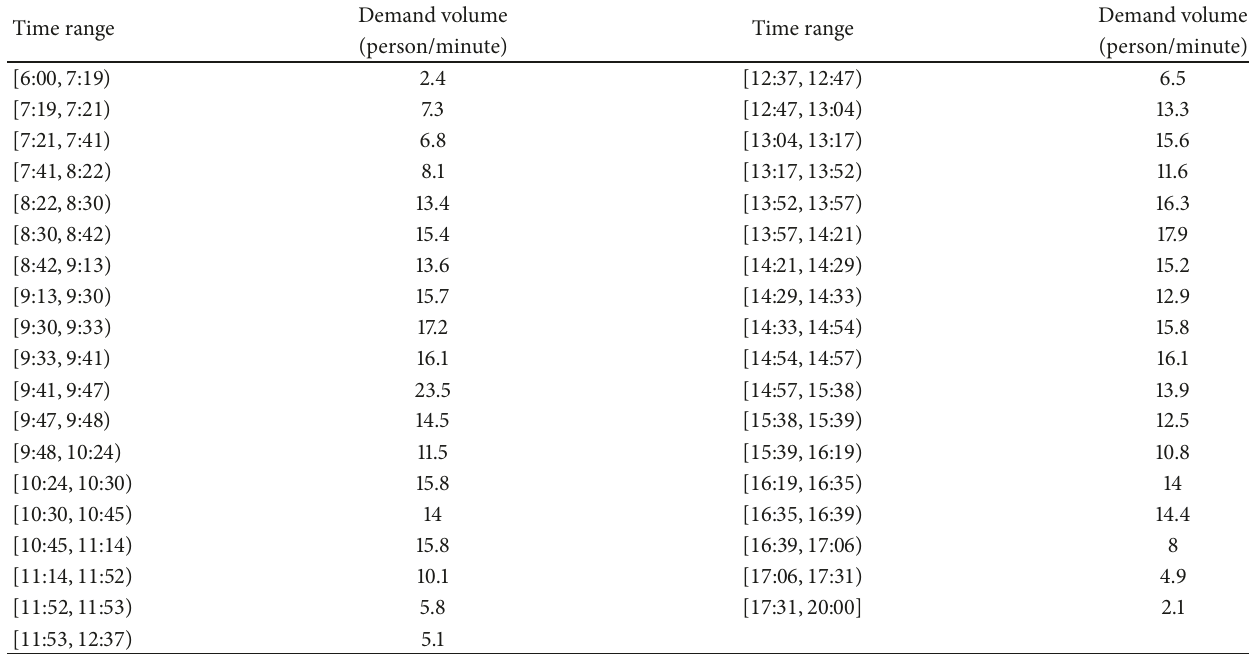
Table 9: The time-varying demand from the MBPRA algorithm. Time range